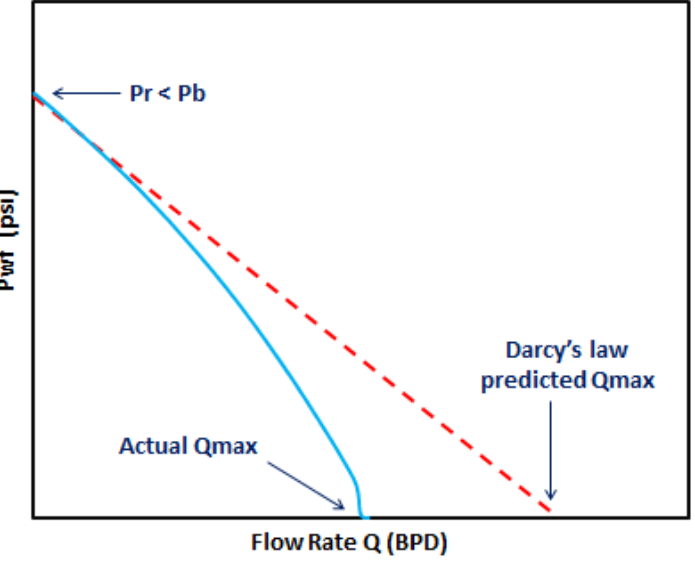
Figure 1. Comparing the straight line IPR predicted by Darcy’s law with the observed actual relationship